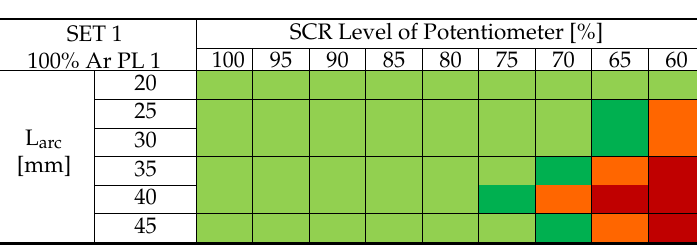
Table 8. Example of an arc stability